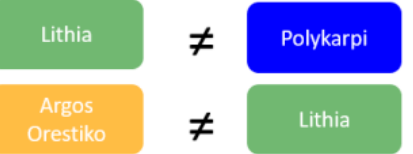
Figure 10 . Statistically significant results of soil texture (numerical data; Clay and Sand).